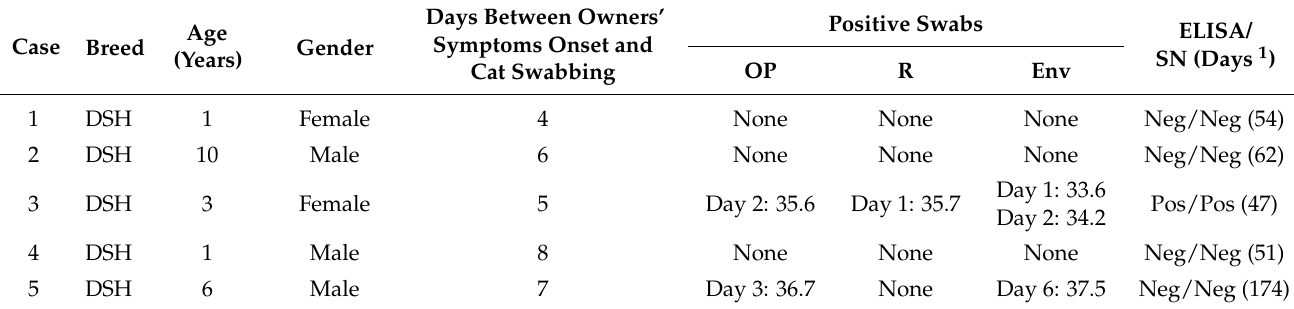
Table 1. Summary of the cases, including breed, age, gender, the time between the onset of owner’s symptoms and cat’s first swab, number, and RT-qPCR Ct values of positive swabs (Day 1 corresponding to the first day the cat was enrolled in the study) and serological status determined by ELISA and serum neutralization